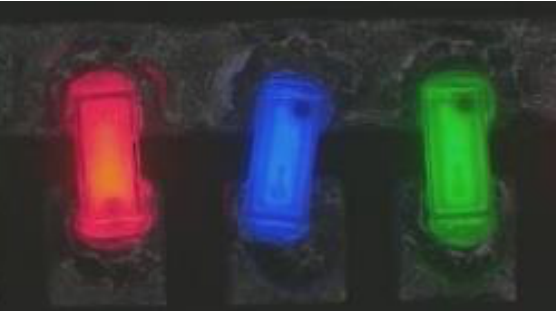
Figure 1. The optical axis of the LED light-emitting chip is offset during bonding (red, blue and green from left to right).